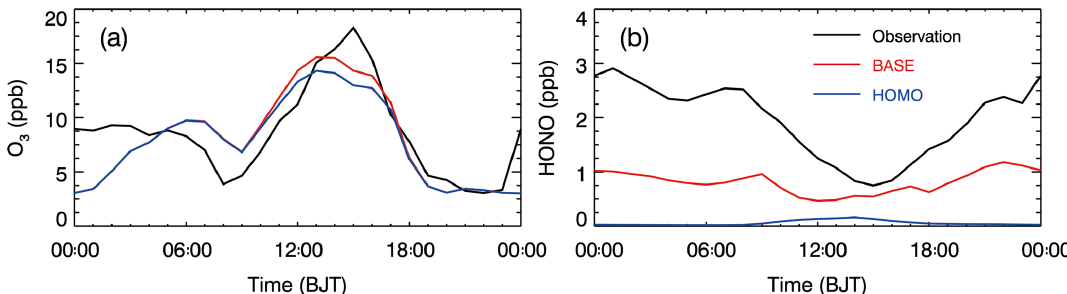
Figure 3. Diurnal cycle of observed (black line) and modeled (solid red and blue lines for the BASE and HOMO cases, respectively) (a) O 3 and (b) HONO concentrations averaged from 9 to 26 January 2014 at the IRSDE site in Beijing.